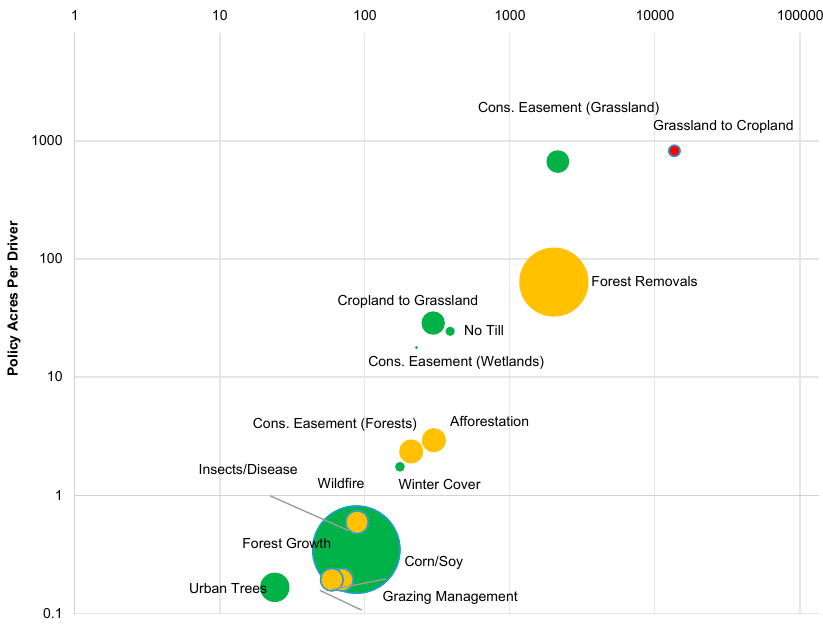
Figure 2. Policy scope and area reach of selected U.S. policies with the potential to influence GHG mitigation in forests and agriculture. Green circles represent net GHG reductions, yellow circles represent uncertain mitigation benefits, and red circles represent net increases in GHG emissions. Source: [4].